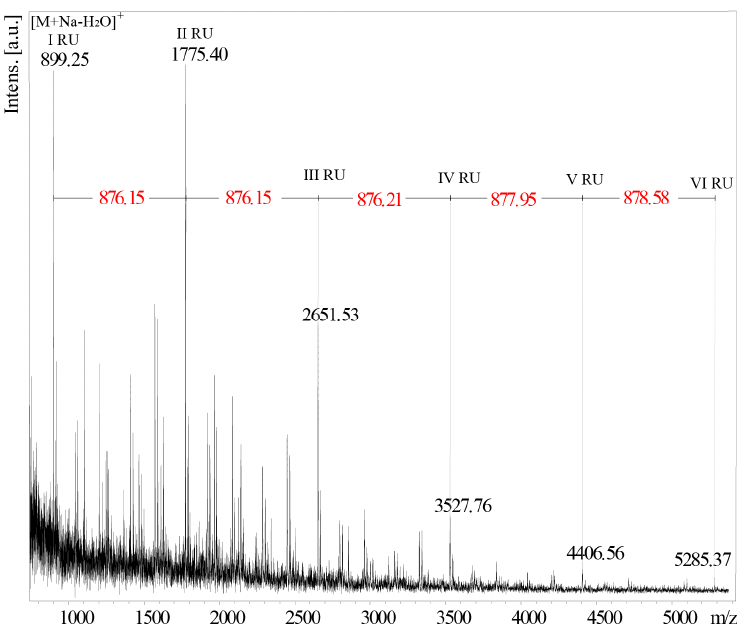
Figure 6. MALDI TOF-MS spectrum of oligosaccharides and trimmed O-PS segments obtained by partial acid hydrolysis of the O-PS I of B. holmesii ATCC 51541 (26th day of the experiment). The spectrum was obtained in the positive reflectron mode with the DHB as a matrix.